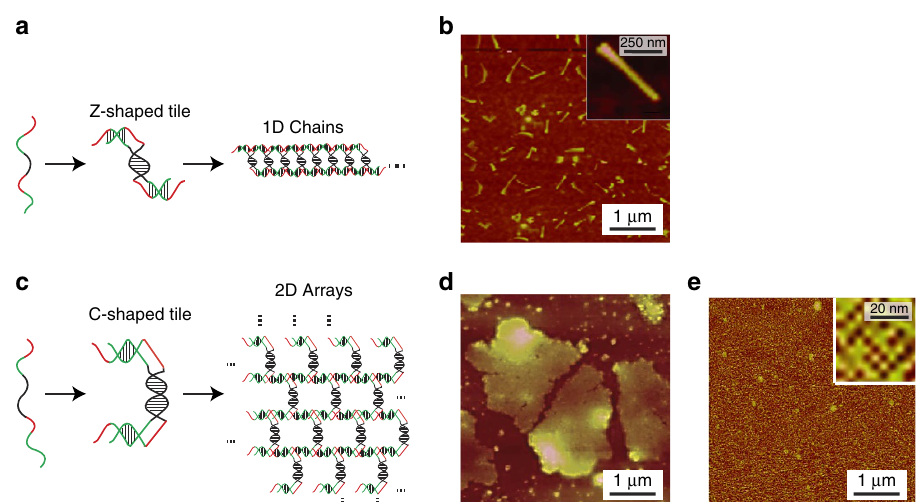
Figure 3 | In vitro assembly of structures using in vivo produced ssDNA. ( a ) The mechanism for the 1D chain formation is shown. The colours on the ssDNA represent different functional domains (black, central palindrome; green, two flanking helical domains; red, T-junction tiles). The ssDNA sequence is added in Supplementary Table 2. ( b ) AFM images of the 1D chain. Insert: zoom-in. ( c ) The mechanism for the formation of 2D arrays is shown, from the self-assembly of a single ssDNA to a 2D DNA periodic arrays. The colours on the ssDNA represent different functional domains (black, a central palindrome; green, two flanking helical domains; red, T-junction tiles). The ssDNA sequence is added in Supplementary Table 2. ( d ) AFM images of the assembly of 2D arrays in solution are shown (Methods). ( e ) AFM images of the 2D arrays assemble using the surface-mediated assembly process (Methods). Inset: zoom-in. Larger-scale AFM images of the 1D chains and 2D arrays are shown in Supplementary Fig.